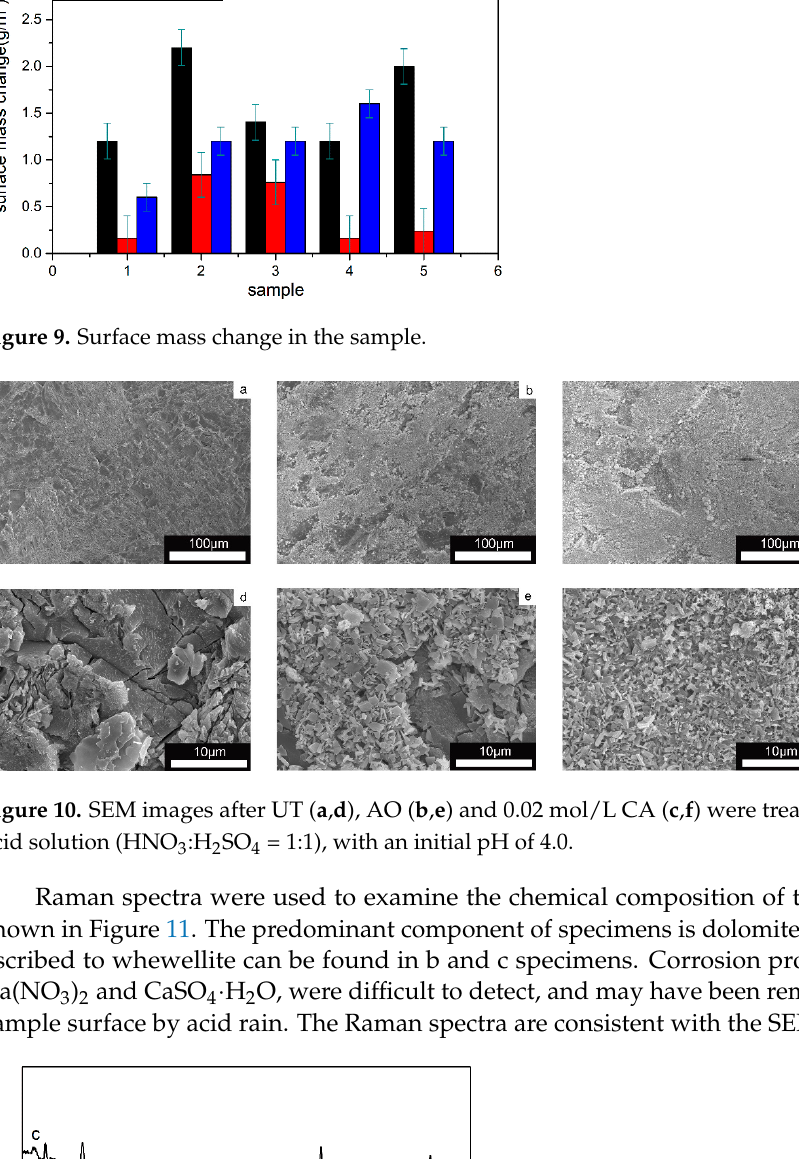
Figure 9. Surface mass change in the sample.